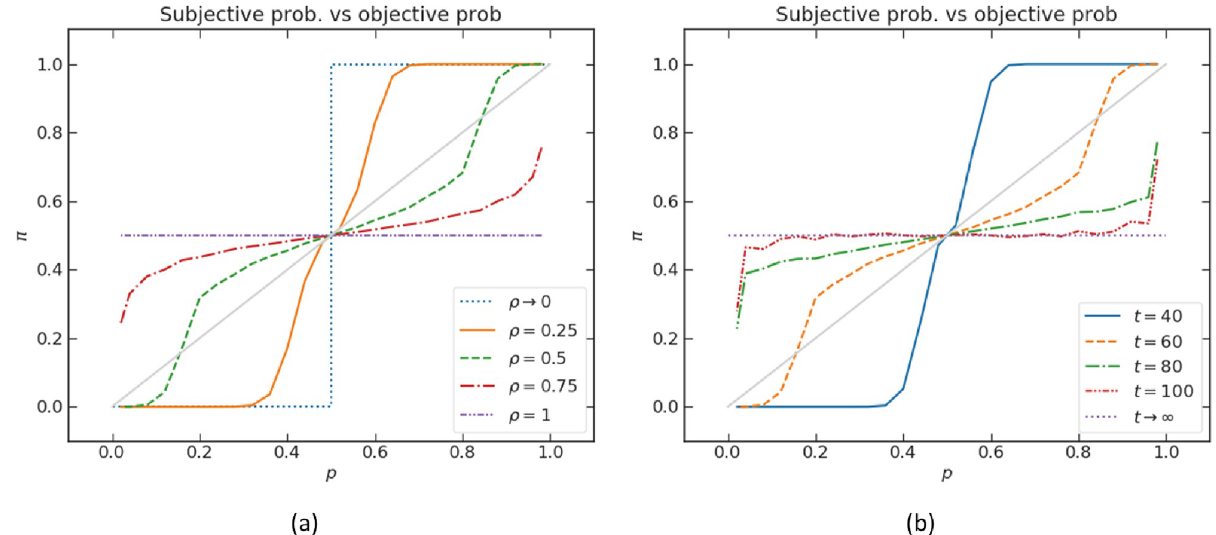
Fig 7. Subjective probability π vs objective probability p . The objective probability p is encoded in the relative lengths of branches explored by the quantum walk, as explained in the text. The walks have unbiased parameters ξ = 0, η = 0.5. The distance between the two boundaries is kept as 50. In (a), π ( p ) is plotted for different values of ρ at fixed t = 60; in (b), π ( p ) is plotted for different values of t at fixed ρ =